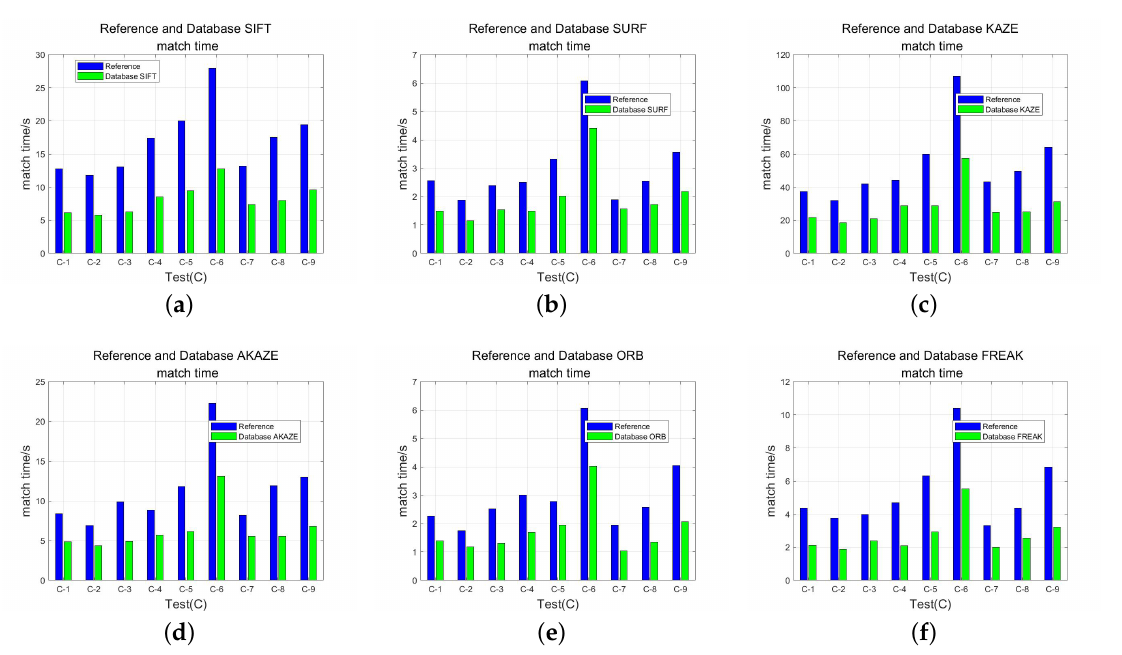
Figure 9. Match time comparison of direct matching method and feature database matching